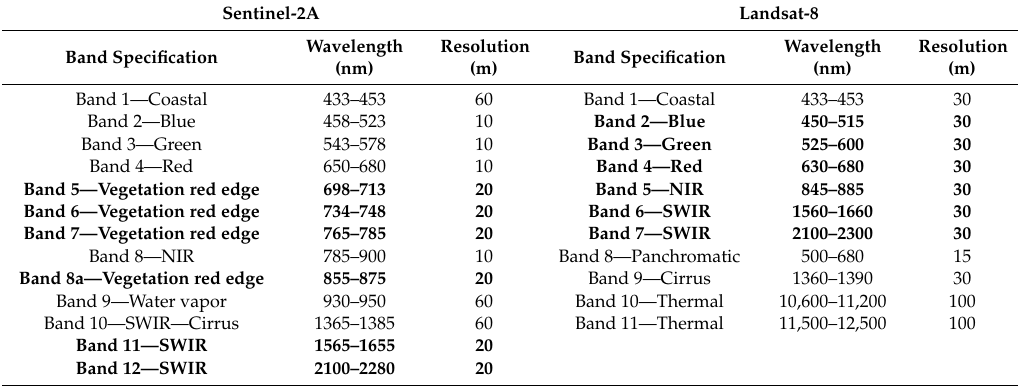
Table 2. Landsat-8-based tillage